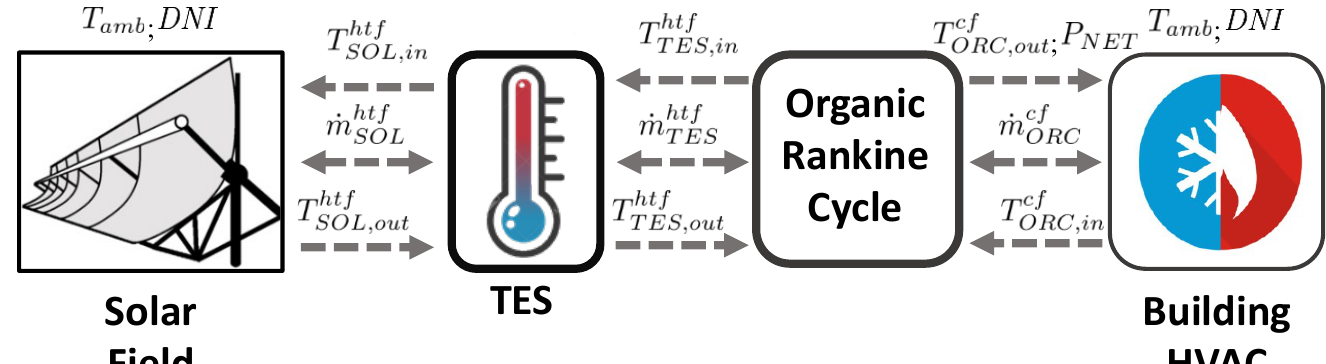
Figure 7. Overview of MicroCSP components models along with system